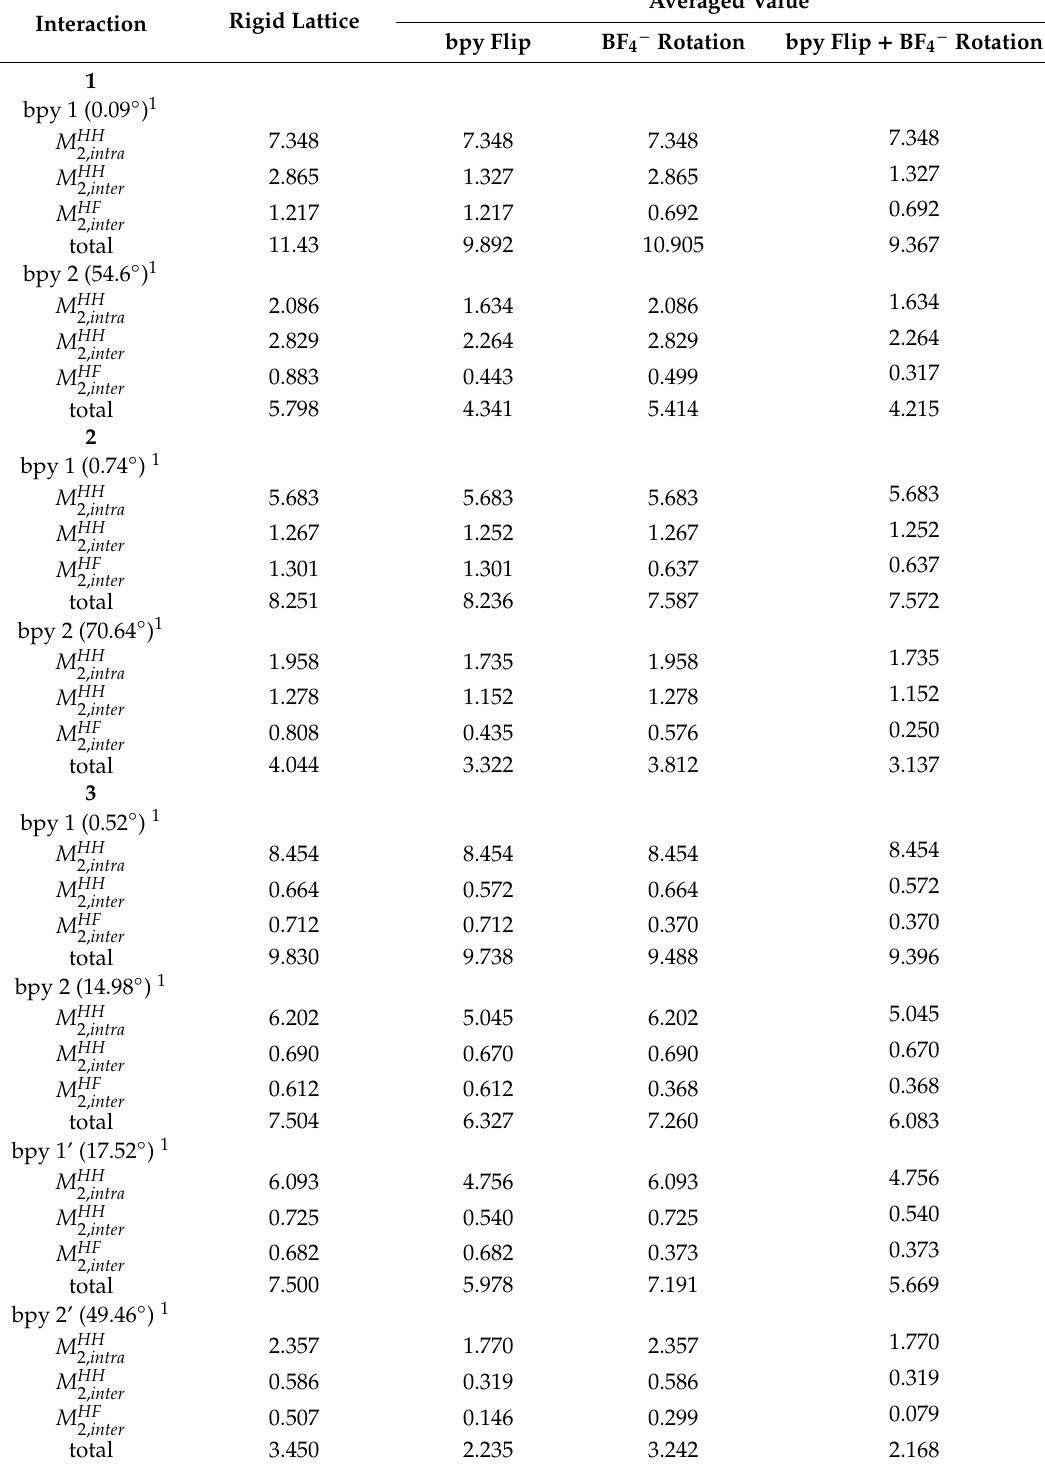
Table A1. 1 H second moments (in 10 − 8 T 2 ) for all ELM-11